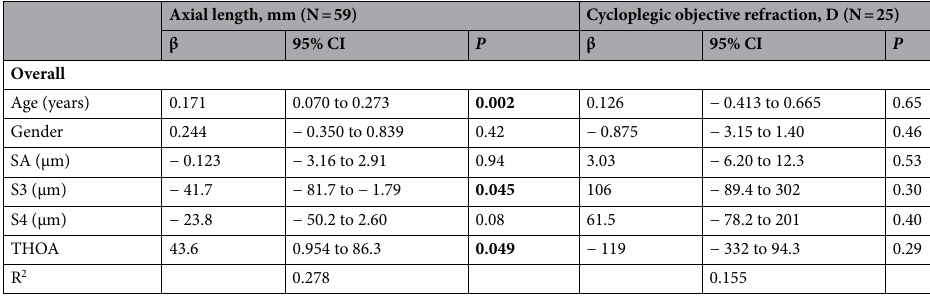
Axial length, mm (N = 59)